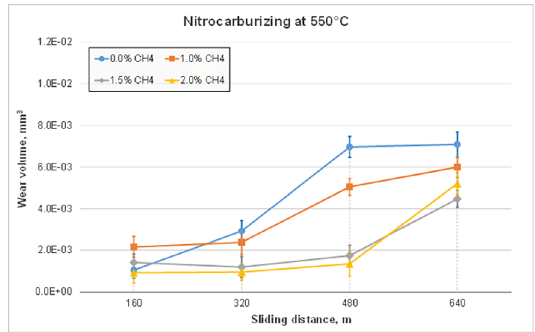
Figure 8. Wear volume for the samples nitrocarburized at 550°C as a function of methane concentration and the sliding distance.